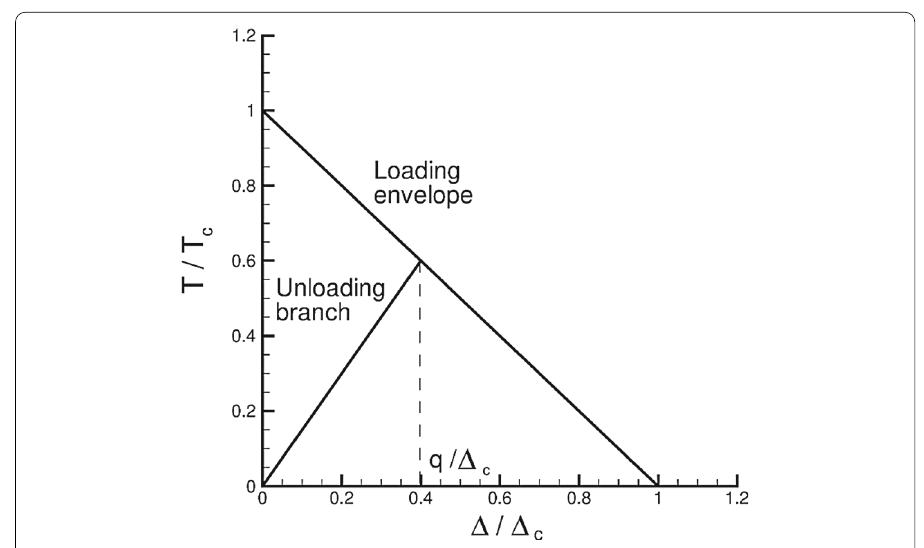
Fig. 1 Linear decreasing cohesive law. The parameters of the model are the cohesive strength T c and the critical energy release rate G c , defined as the area enclosed by the linear loading